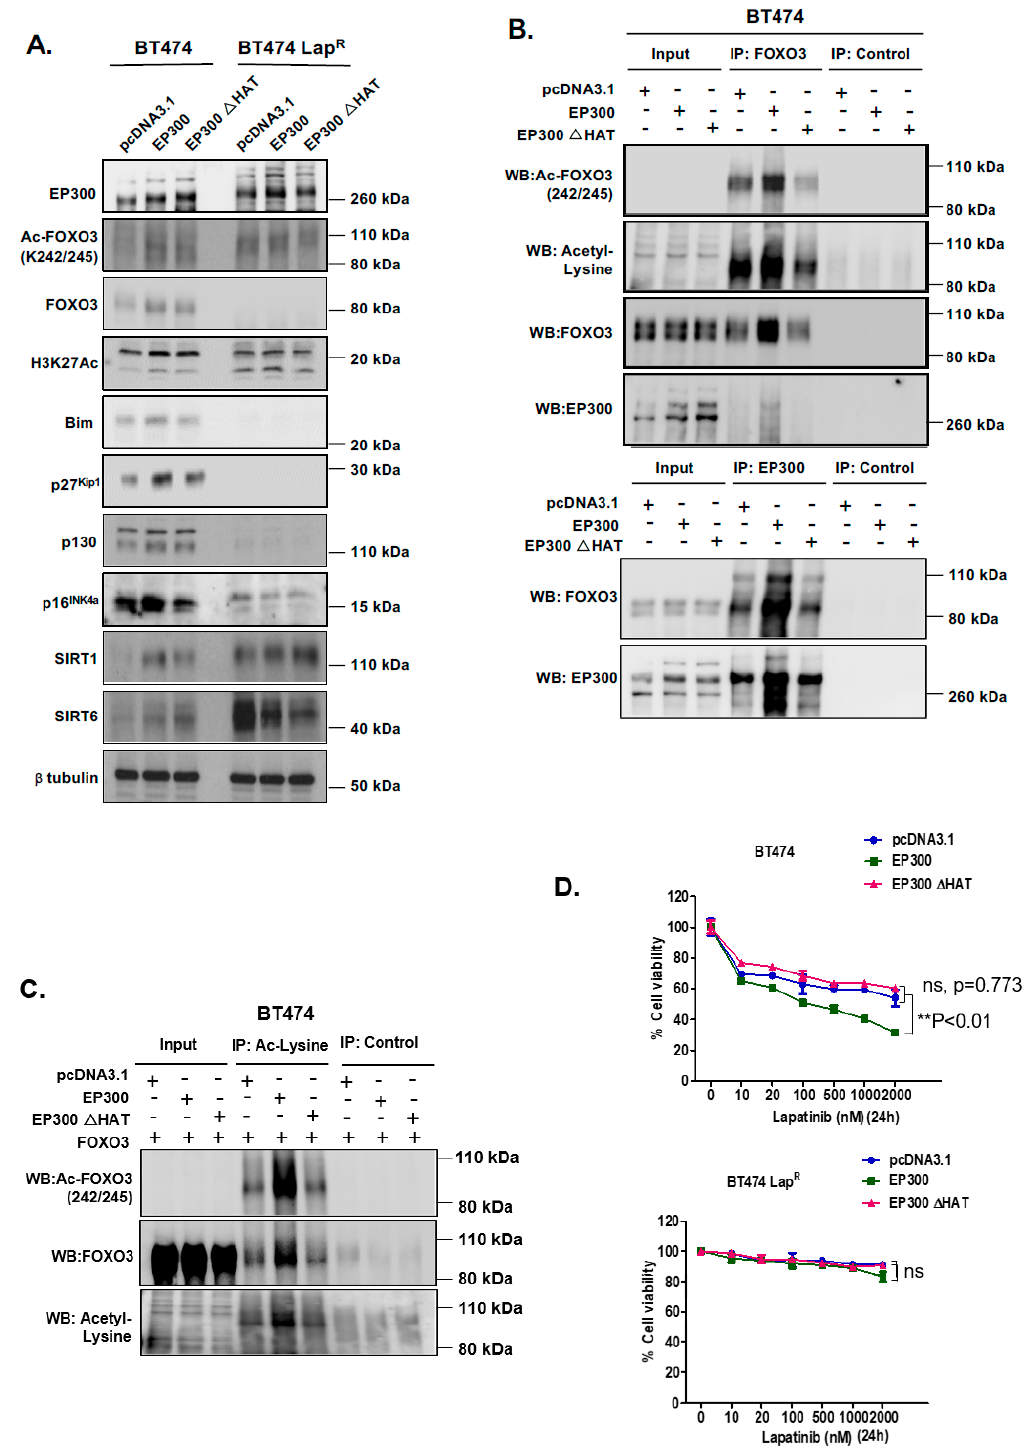
Figure 4. EP300 overexpression upregulates FOXO3 acetylation/activity and increases lapatinib sensitivity. ( A ) BT474 and BT474-Lap R cells were transiently transfected with the empty vector pcDNA3.1, the plasmid encoding wild-type EP300 or the one encoding for its acetyl-transferase mutant derivative (EP300 ∆ HAT). Proteins were obtained from whole cell extracts after 24 h following transfection. Western blotting was performed using the protein lysates to assess the expression levels of EP300, FOXO3 and other indicated proteins. ( B ) Protein lysates of BT474 cells transiently transfected with EP300 or EP300 ∆ HAT obtained were assessed by Co-immunoprecipitation